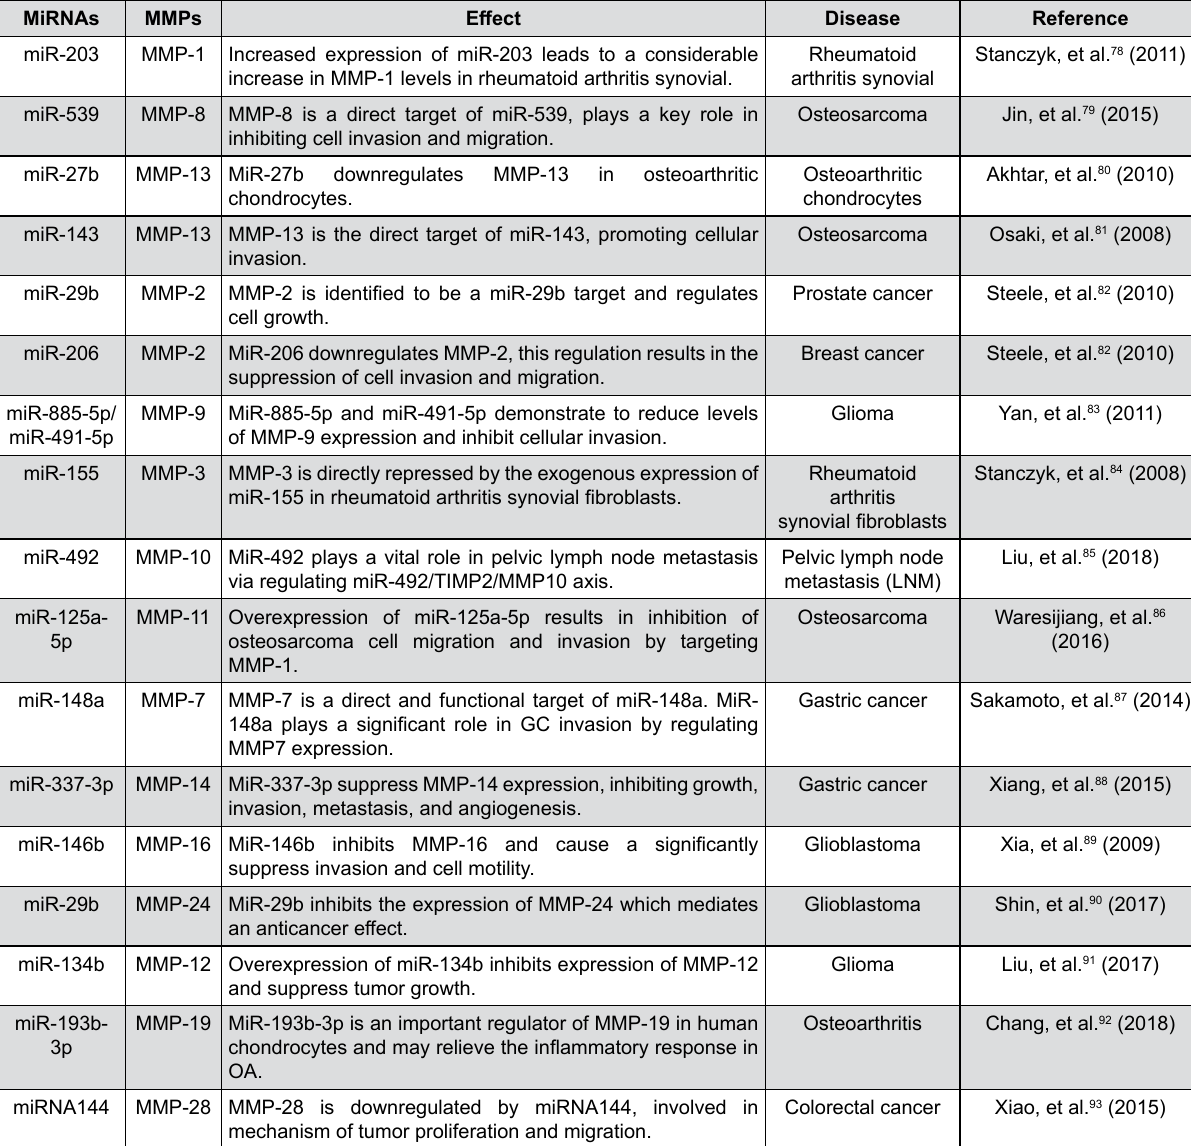
Figure 5- Summary of the miRNAs effect over MMPs in some diseases